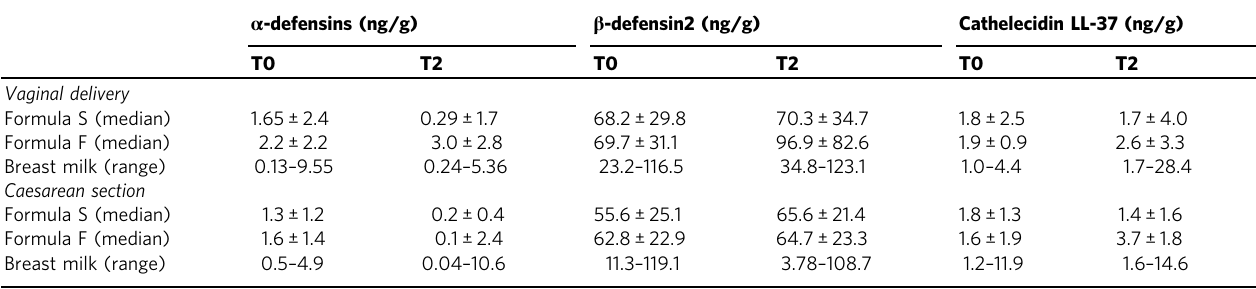
Table 3 Antimicrobial peptides at each study point according to randomisation group and mode of